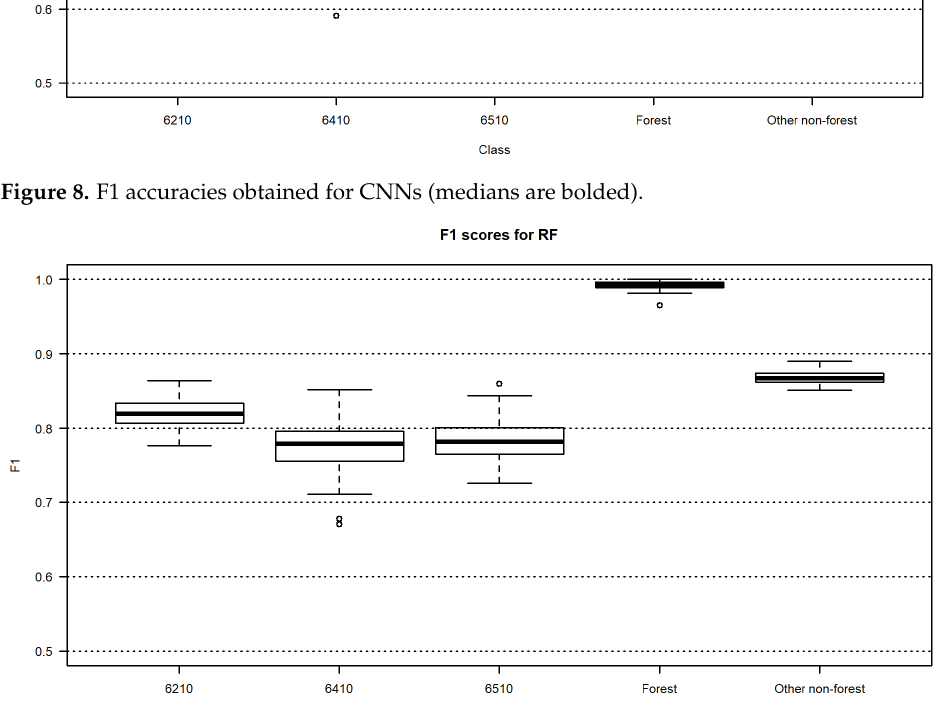
Figure 9. F1 accuracies obtained for RF (medians are bolded).